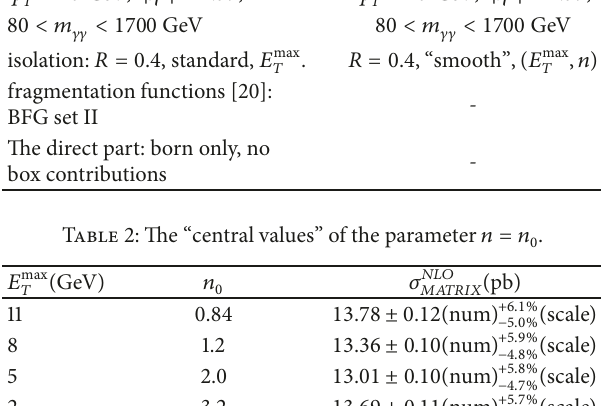
data exp. uncert.